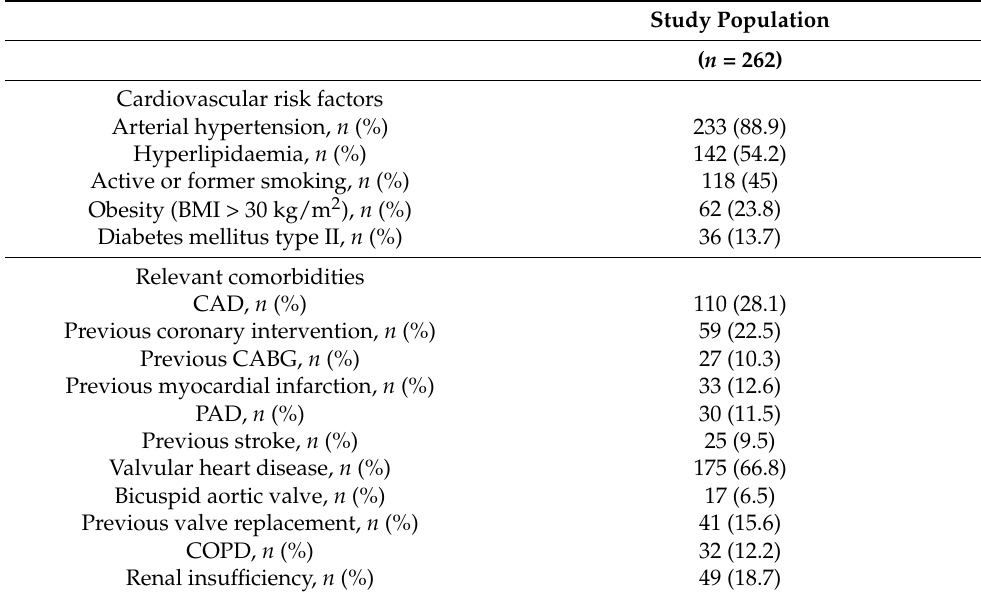
Table 2. Cardiovascular risk factors and